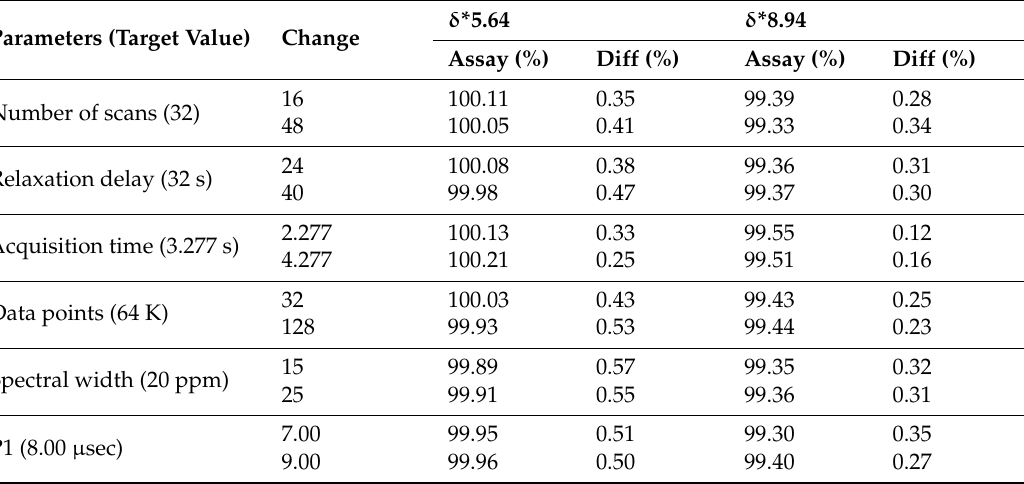
Table 4. Robustness results of Orlistat purity determination.